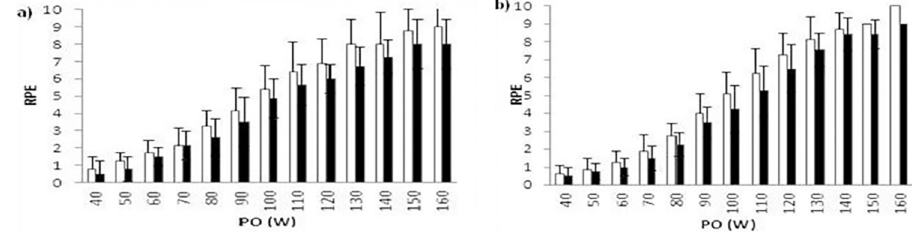
Fig 3. Local (white bar) and overall (black bar) perceived exertion during. a) handcycling before training and b) handcycling after